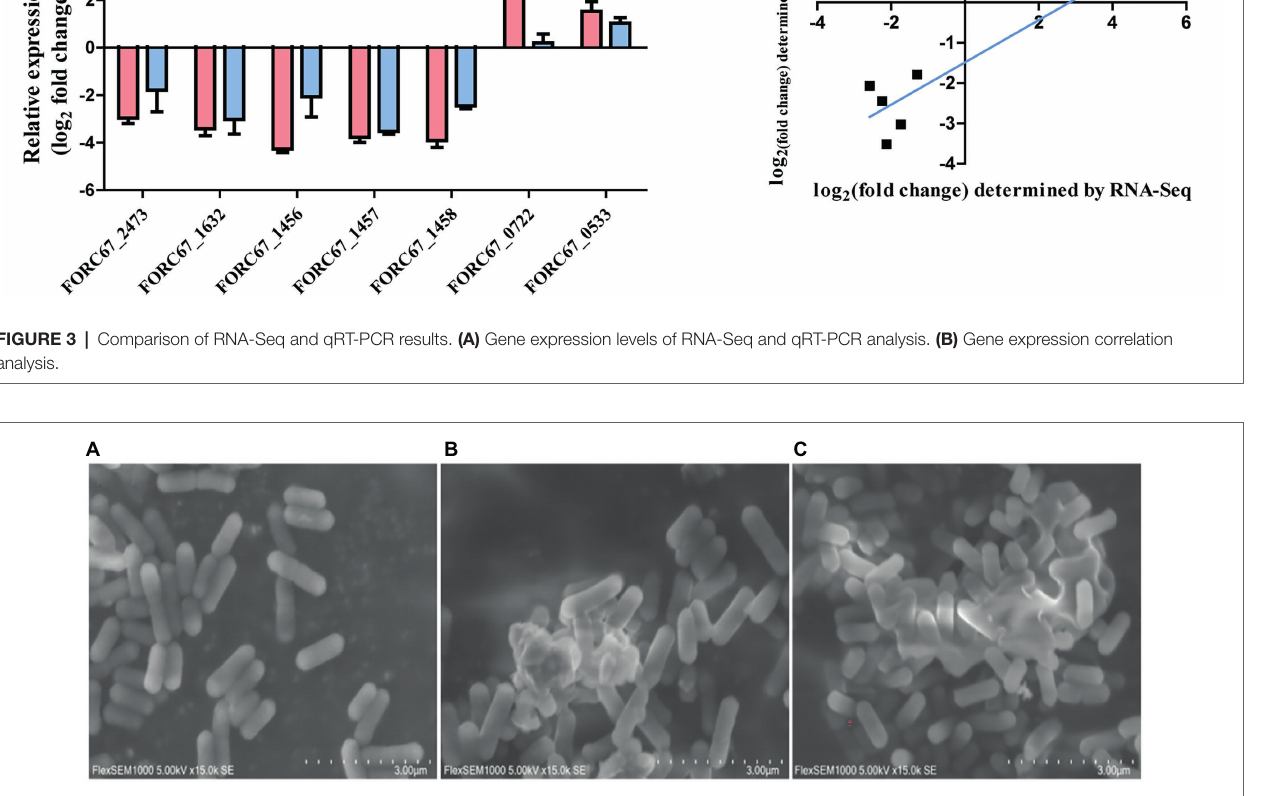
FIGURE 4 | Effect of moringin on the surface structure and morphology of Listeria monocytogenes by SEM. (A) Untreated Listeria monocytogenes . (B) Listeria monocytogenes treated with moringin at 1/2 MIC. (C) Listeria monocytogenes treated with moringin at 1